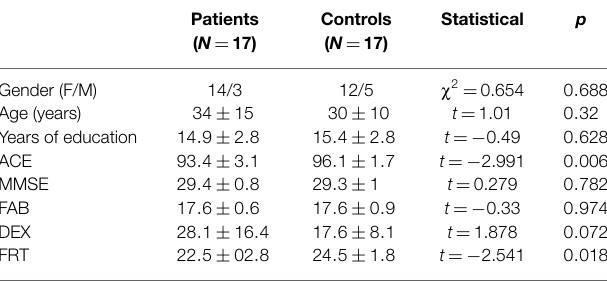
TABLE 2 | Demographic and neuropsychological characteristics of both groups